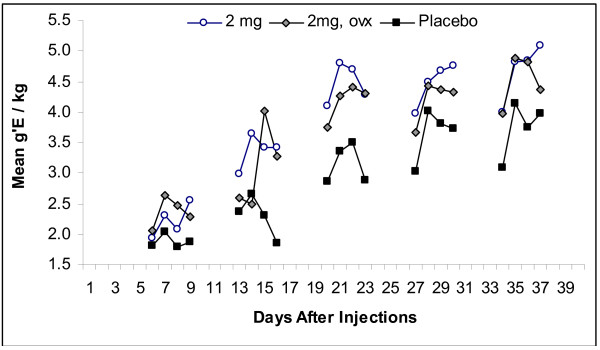
Mean Grams of Ethanol Taken for Each Day of Presentation of 12% Ethanol Solution for Three Groups of Subjects. The mean intakes for each day of presentation of alcoholic beverage for three groups of subjects, a placebo-control group and two groups that had received 2 mg of estradiol valerate (n = 10 a group), one of which had ovariectomies. Notice that there is considerable variation associated with days within weeks. More importantly, notice that the intakes of the two groups receiving 2 mg of EV drank more during the 3rd, 4th, and 5th week of opportunity to do so.